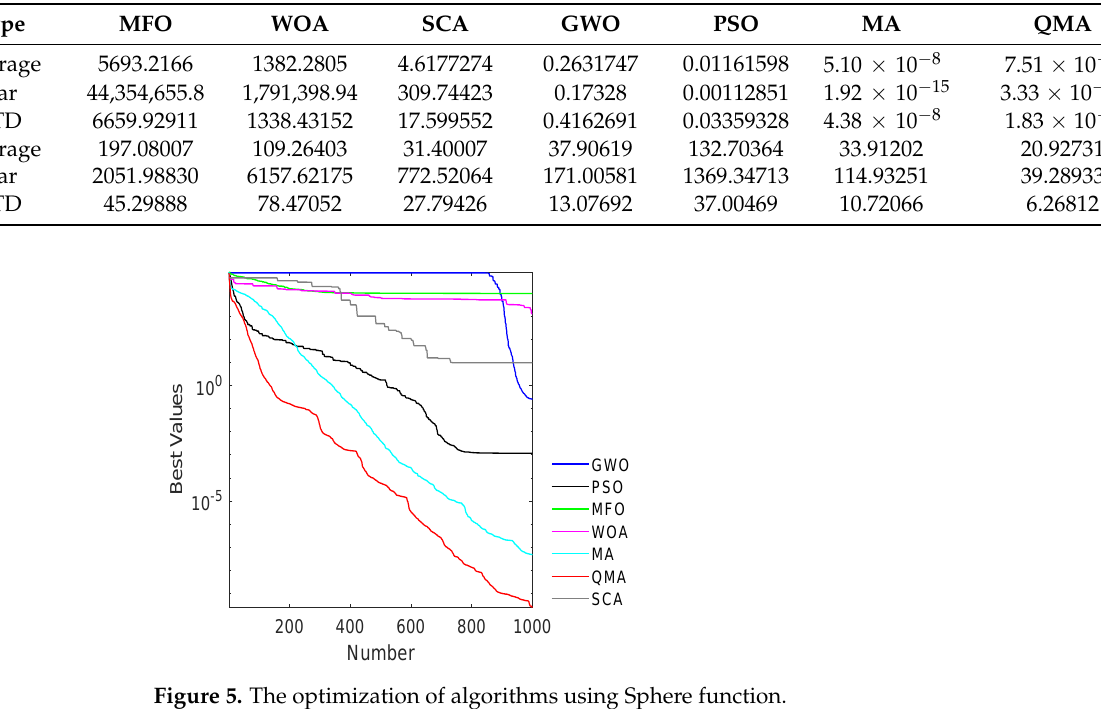
Table 4. Comparison results in different algorithms.